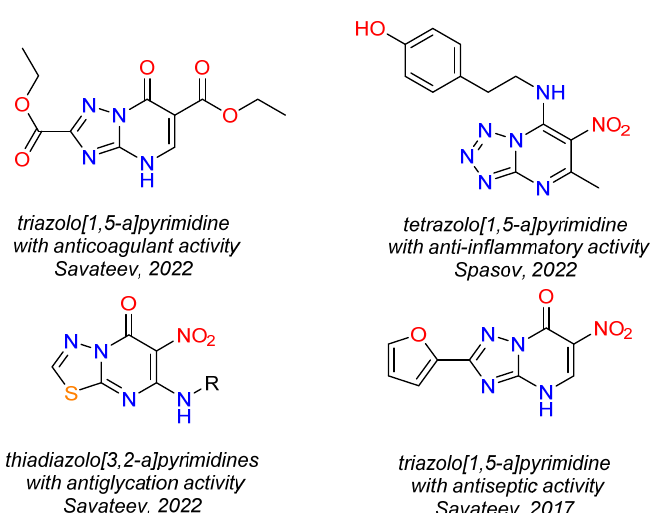
Figure 2. Examples of biologically active azolopyrimidines [16–18,20].